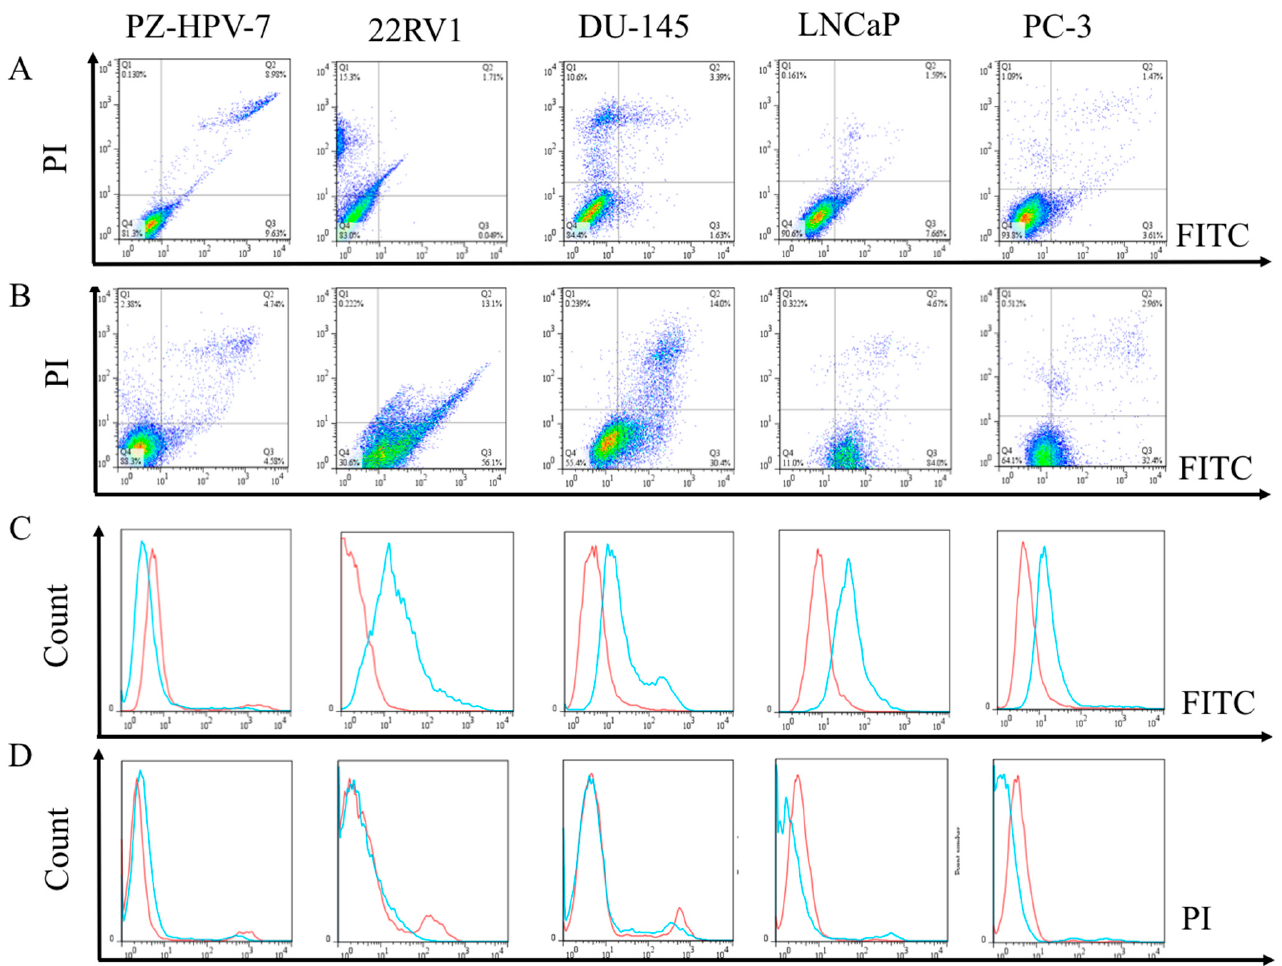
Figure 6 . Flow cytometric analysis indicating that most of the tumor cells progressed towards apoptosis. ( A ) Original cells. ( B ) Cells after treatment with 20 µ M of EPA. ( C ) The intensity of fluorescein isothiocyanate (FITC) labelled on cells shows the degree of cell apoptosis; red curves represent the original cells and blue curves represent cells after treatment with EPA—this is also shown on the right-hand side of the four-quadrant axes in ( A , B ). ( D ) The intensity of propidium iodide (PI) shows the degree of cell necrosis; red curves represent the original cells and blue curves represent cells after treatment with EPA—this is also shown on the upper side of the four-quadrant axes in A and B. Cells located in Q1 or Q2 zones tended towards necrosis; cells in the bottom right of the four-quadrant axis (Q3 zone) tended towards early apoptosis; cells in the Q4 zone were healthy.